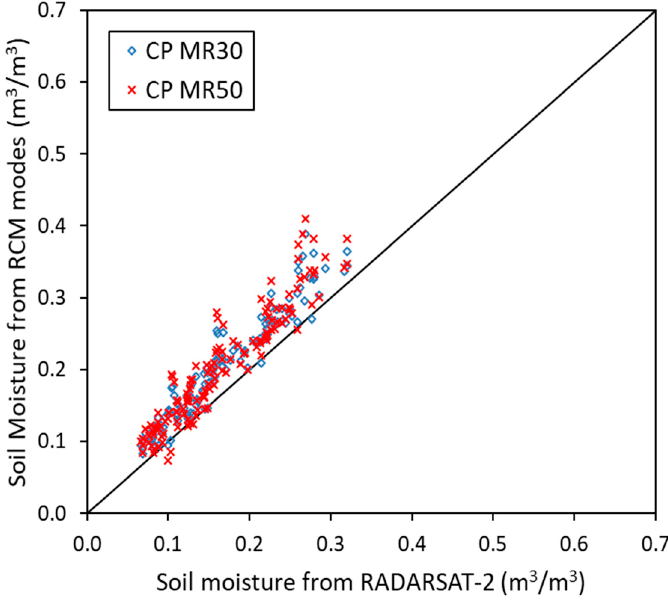
Figure 5. Comparison between retrieved soil moisture values from RADARSAT-2 and simulated RCM CP. Table 3. Estimation error statistics between RADARSAT Constellation Mission (RCM) CP (RH and RV) and RADARSAT-2 (HH and VV) soil moisture retrievals.